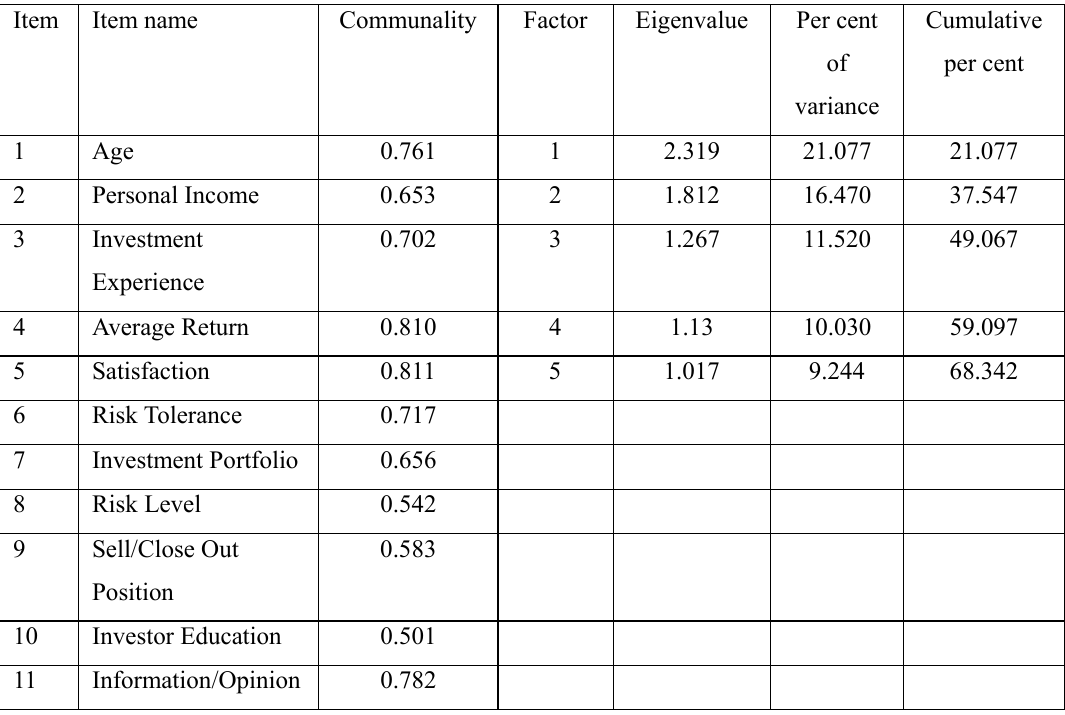
Table 4: Principle component